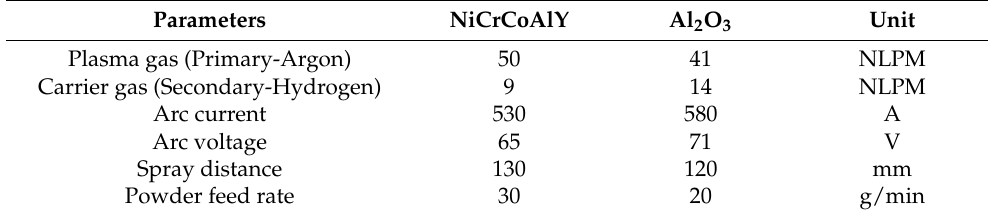
Table 2. Process parameters of plasma